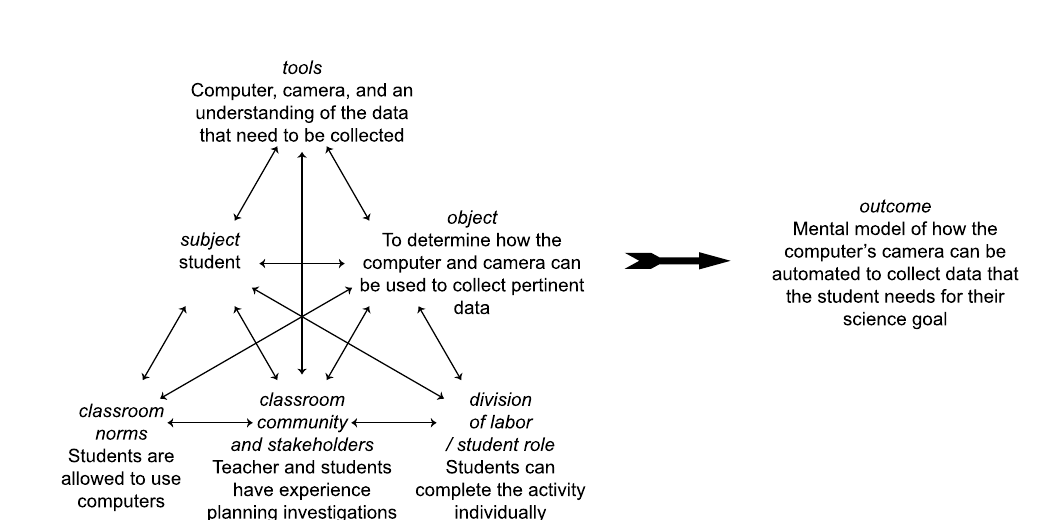
Fig. 5 Design of a computational tool for data collection activity